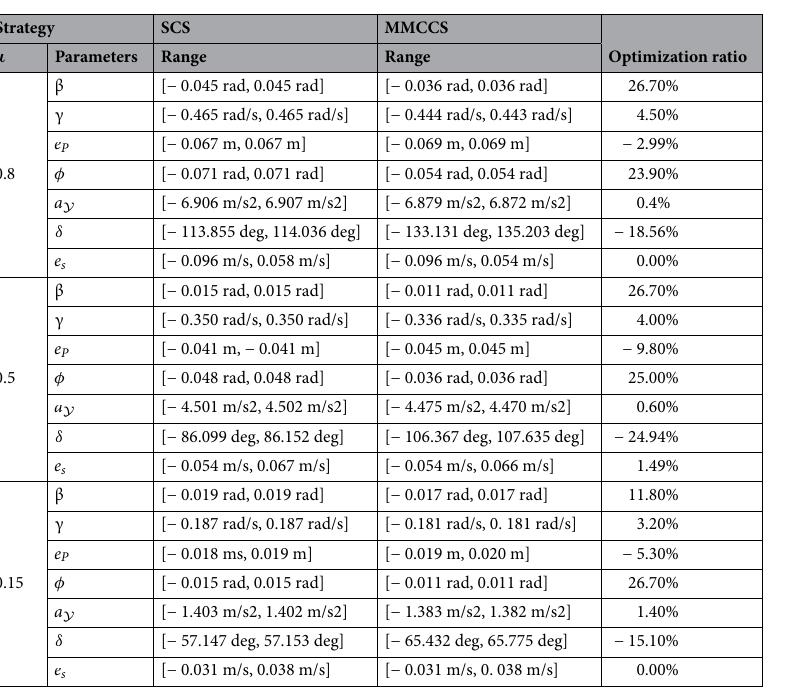
Table 2. Summary of DDAVs double-line-shift and serpentine driving simulation